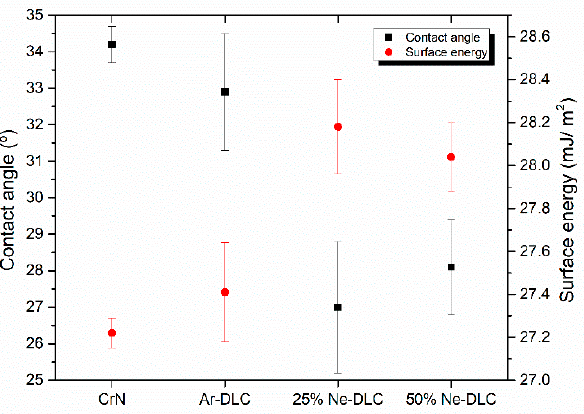
Figure 5. Contact angle measurements and surface free energy of the coating films.